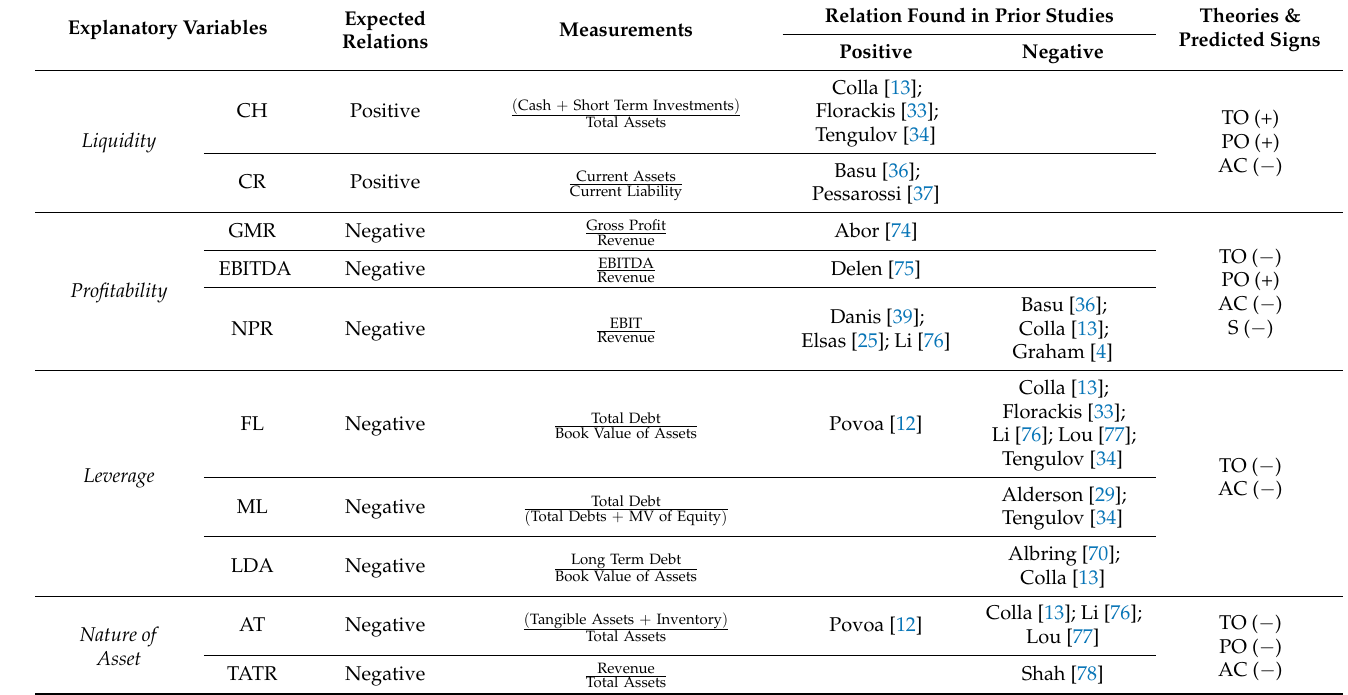
Table 1. Summary for predictors of debt